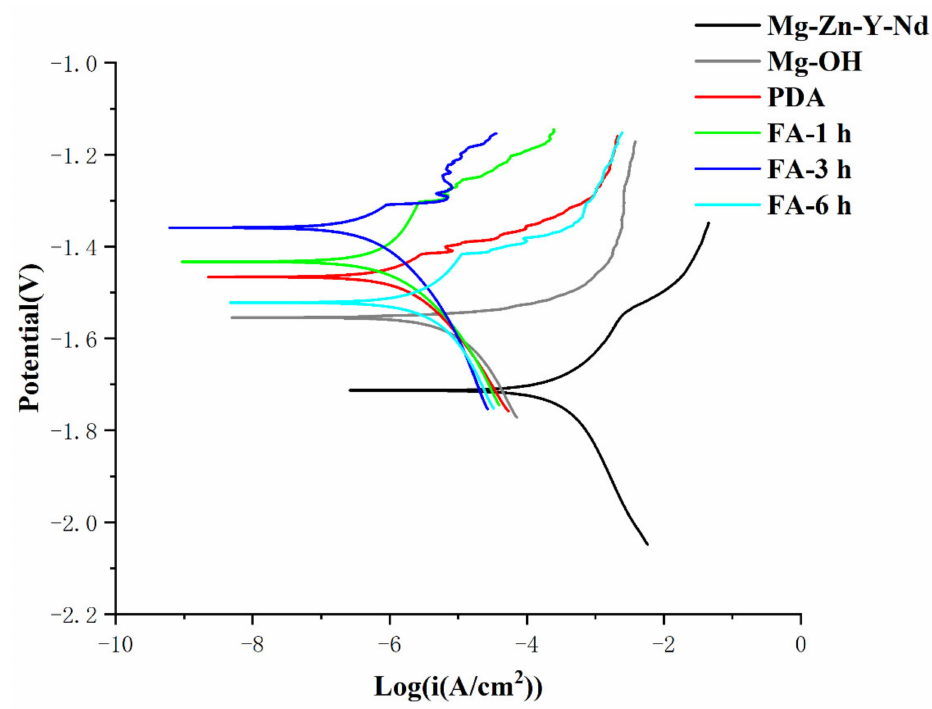
Figure 7. Potentiodynamic polarization plots of